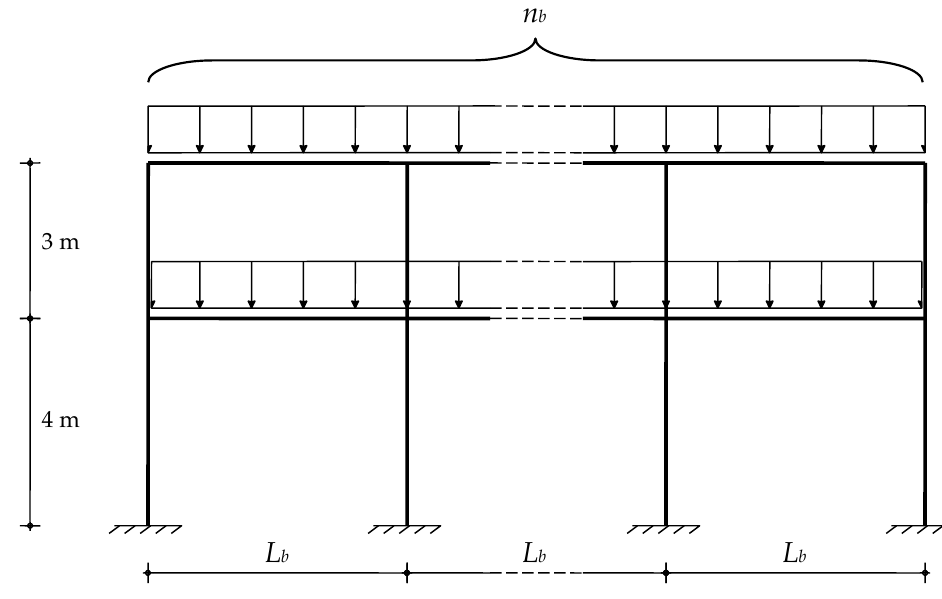
Figure 5. Schematization of the studied concrete frames.